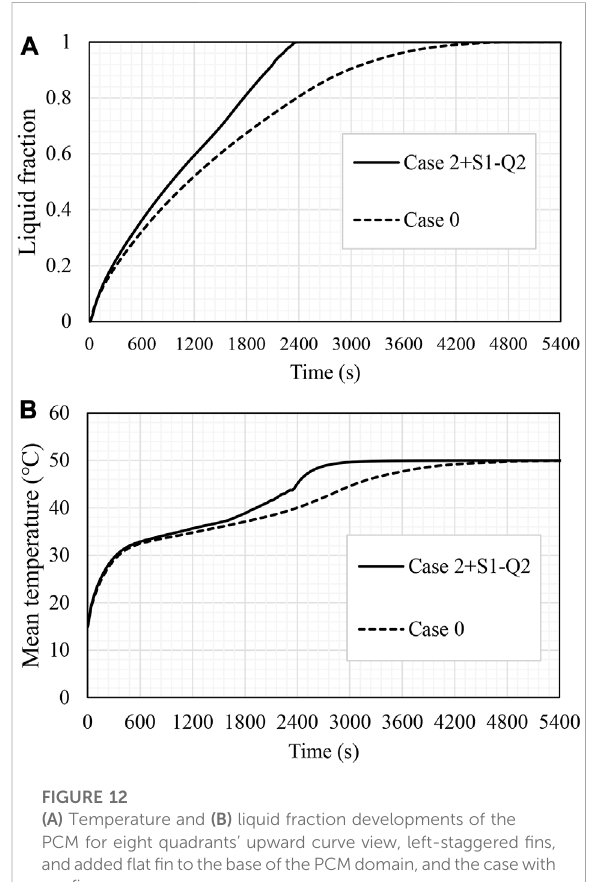
FIGURE 12 (A) Temperature and (B) liquid fraction developments of the PCM for eight quadrants ’ upward curve view, left-staggered fi ns, andadded fl at fi ntothebaseofthePCMdomain,andthecasewith no- fi